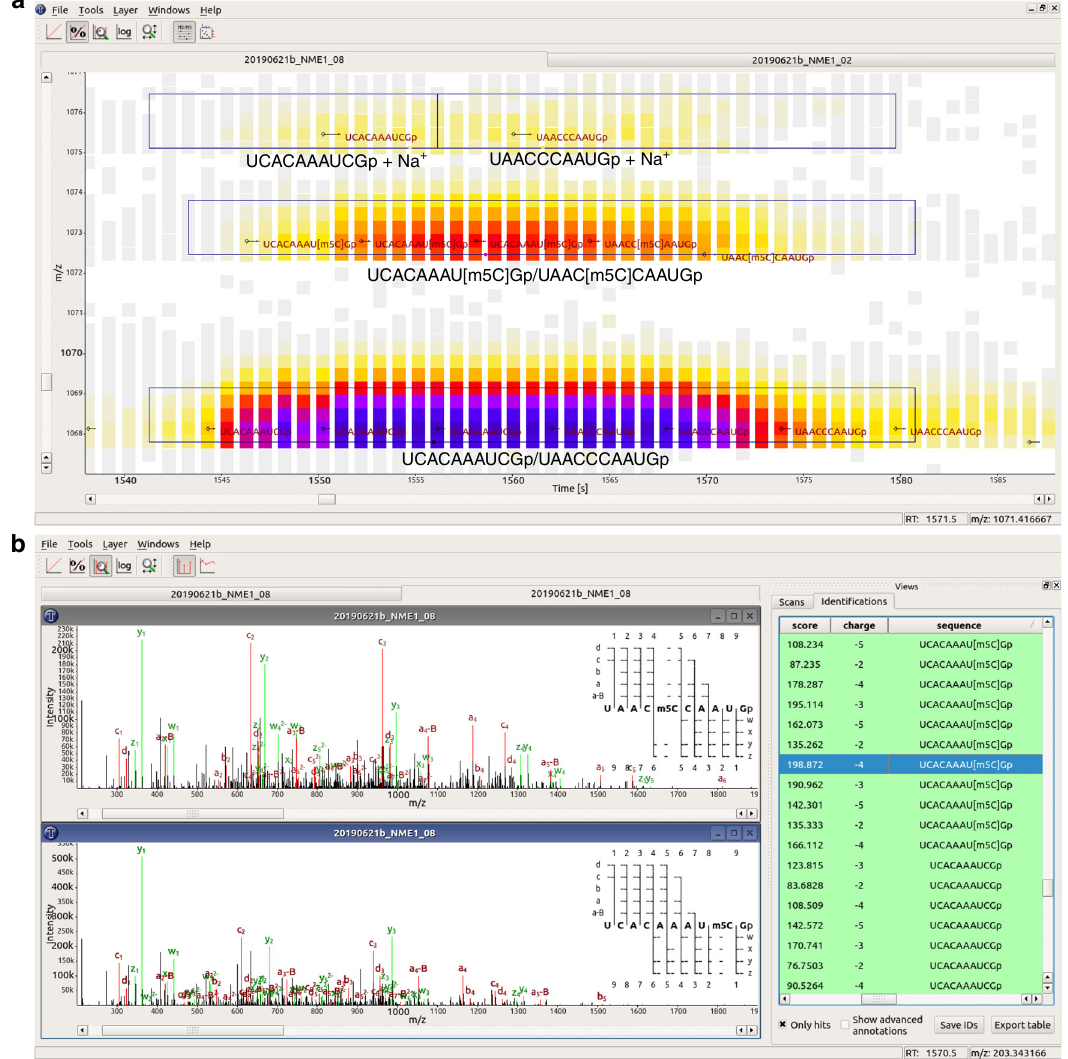
Fig. 4 Interactive data visualization using TOPPView, showing data from the NCL1-treated NME1 sample. a MS1 view (RT-by-m/z) of a data section. LC-MS peaks are shown as small squares, colored according to their signal intensities. Small black diamonds and horizontal lines indicate MS2 fragmentation events; oligonucleotide sequences identi fi ed by NASE from the MS2 spectra are shown in dark red font. Black boxes outline features detected for label-free quanti fi cation, which have been annotated with the corresponding oligonucleotides. All oligonucleotides shown have a charge state of − 3. b “ Identi fi cation view ” comparing two MS2 spectra, identi fi ed by NASE as the sequences “ UAAC[m5C]CAAUGp ” and “ UCACAAAU[m5C]Gp ” . Matching peaks between the acquired and theoretical spectra are annotated and highlighted in red and green. On the right in each spectrum plot, an ion coverage diagram shows which of the theoretical fragment ions of the sequence were matched in the MS2 spectrum (in any charge